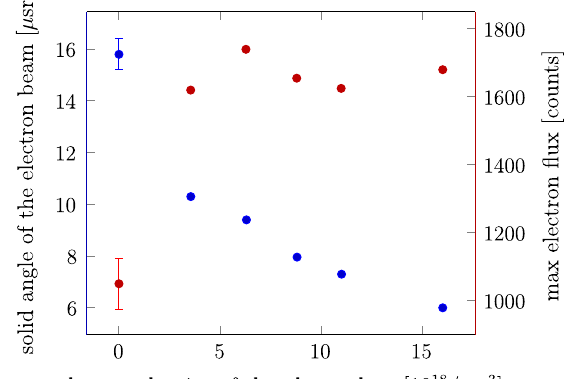
FIG. 3. Solid angle and maximum electron flux depending on the density of the focusing plasma: The solid angle (left axis, blue) of the electron beam decreases as the plasma density ¼ 8 . 75 mm for increases. The gap length was kept constant at L g all measurements. Each point is calculated from an averaged and center-aligned (see text) beam profile over 150 to 250 shots. The reference with the lensing stage turned off (density ¼ 0 ) has been measured at the beginning, middle and end of the scan. The error bars indicate the standard deviation ( (cid:3) 1 σ ) of these measure- ments. The error is similar for all measurements. The density measurements were taken using a wavefront sensor, resulting in an error of (cid:3) 0 . 5 × 10 19 = cm 3 . The red curve (right axis) shows the peak electron flux on the scintillation screen.